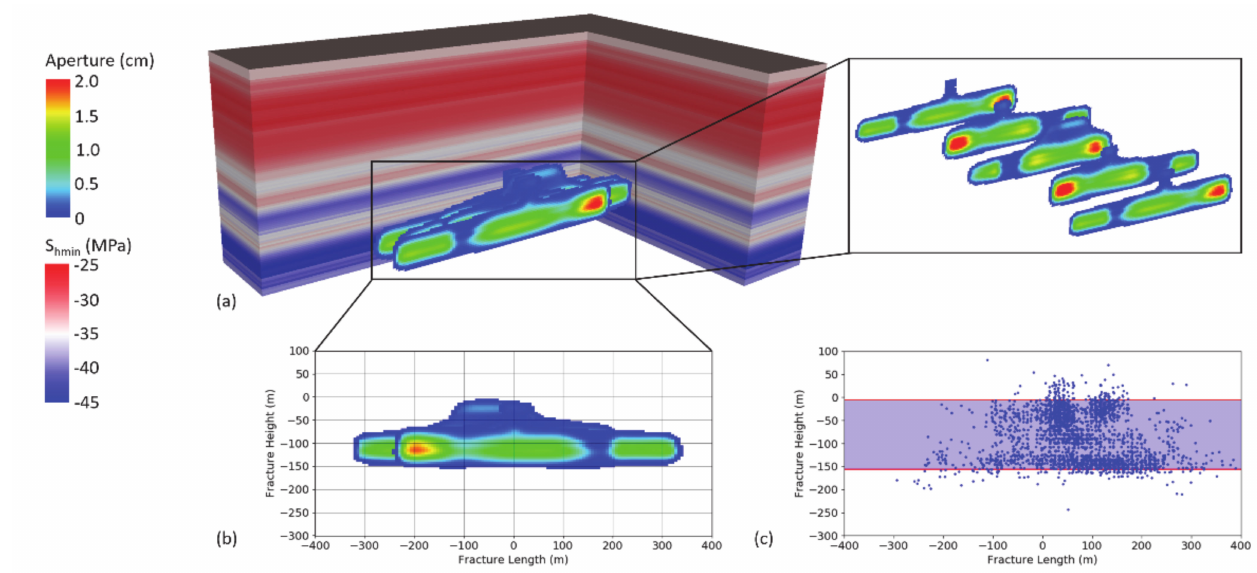
Figure 6. GEOS simulation results and microseismic data. ( a ) Fracture aperture and minimum horizontal stress distributions; ( b ) simulated fracture geometry and aperture, front view; ( c ) fracture extent indicated by microseismic event